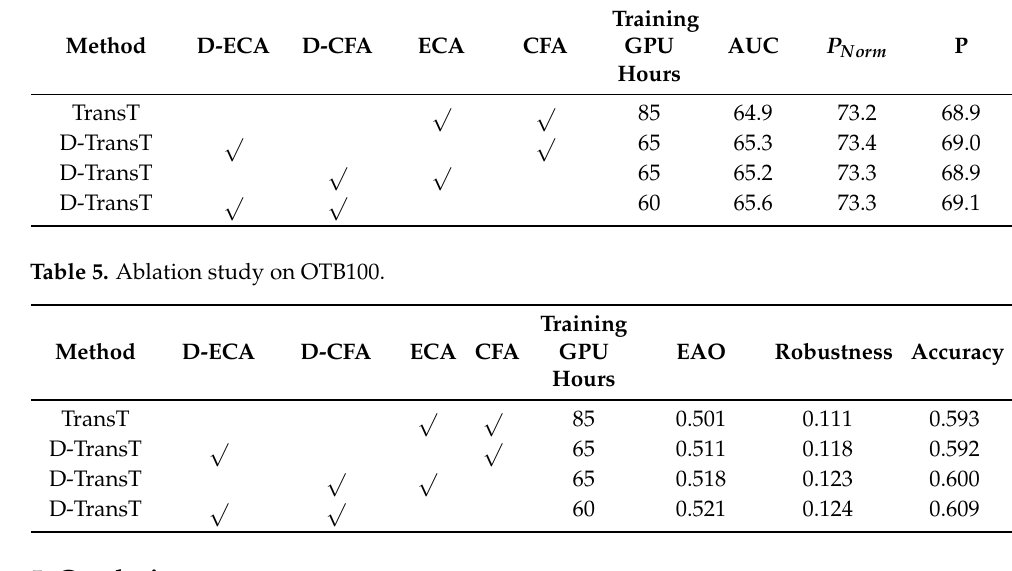
Table 4. Ablation study on LaSOT.